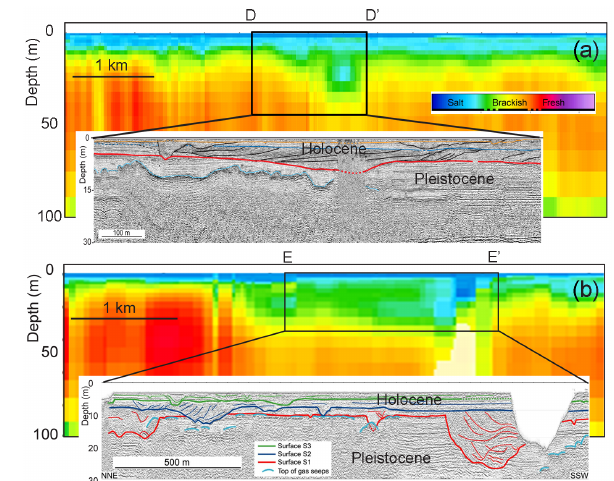
Figure 4. Vertical resistivity and seismic sections along the align- ments D–D (cid:48) (a) and E–E (cid:48) (b) sketched in Fig. 1. The red line repre- sents the Pleistocene–Holocene